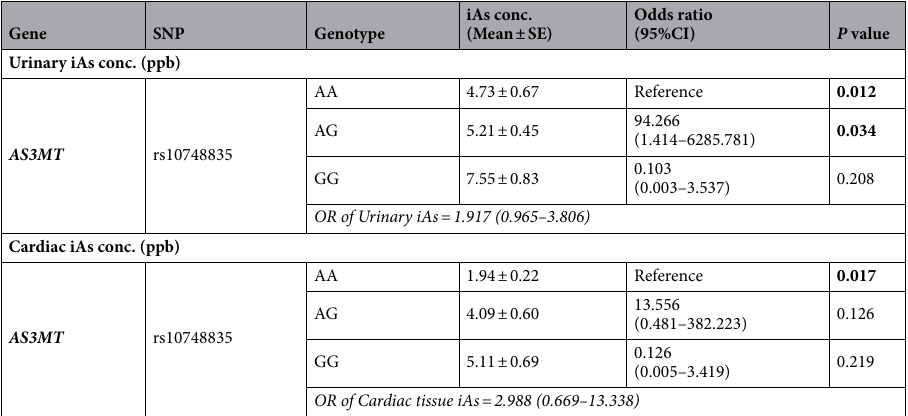
Table 3. Association between AS3MT rs10748835 polymorphism and total inorganic arsenic concentration in urine and cardiac tissues of patients. Here, binary logistic regression was done by adjusting the association with patients’ age, sex, BMI, hypertension and diabetes status. There was no association between the AS3MT polymorphism and nail arsenic concentration (data not shown). The significant values ( P < 0.05) are typed in bold